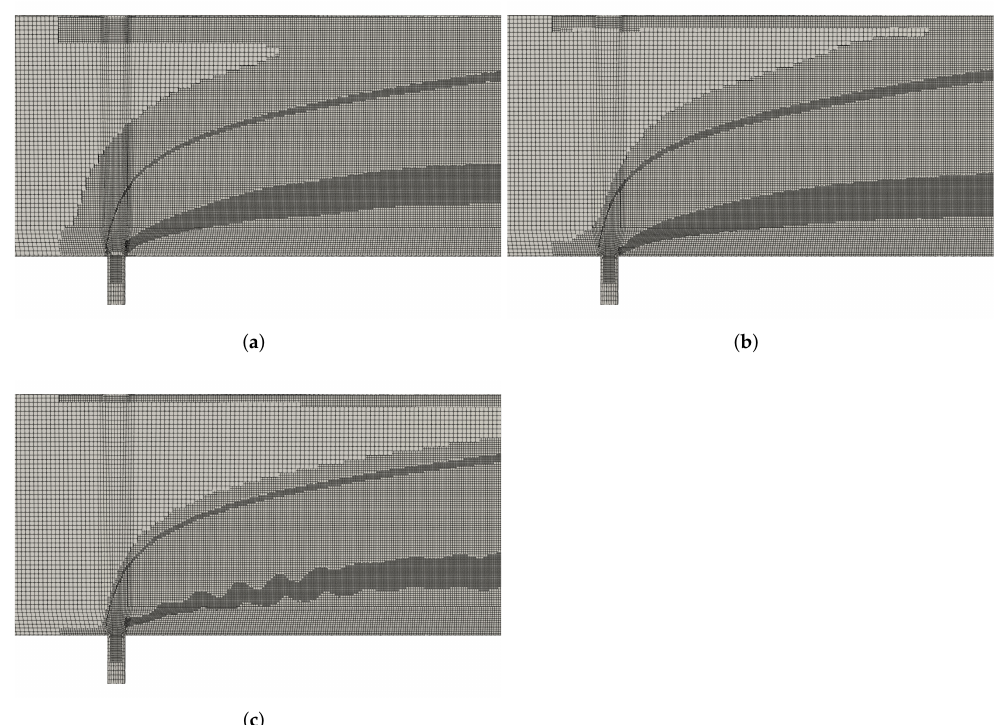
Figure 6. Grids generated using the AMR approach. Variances in mesh refinement are a direct conse- quence of innate differences between turbulence models. Images are fragments of the computational domain: ( a ) k − (cid:101) model; ( b ) k − ω TNT model; ( c ) k − ω SST